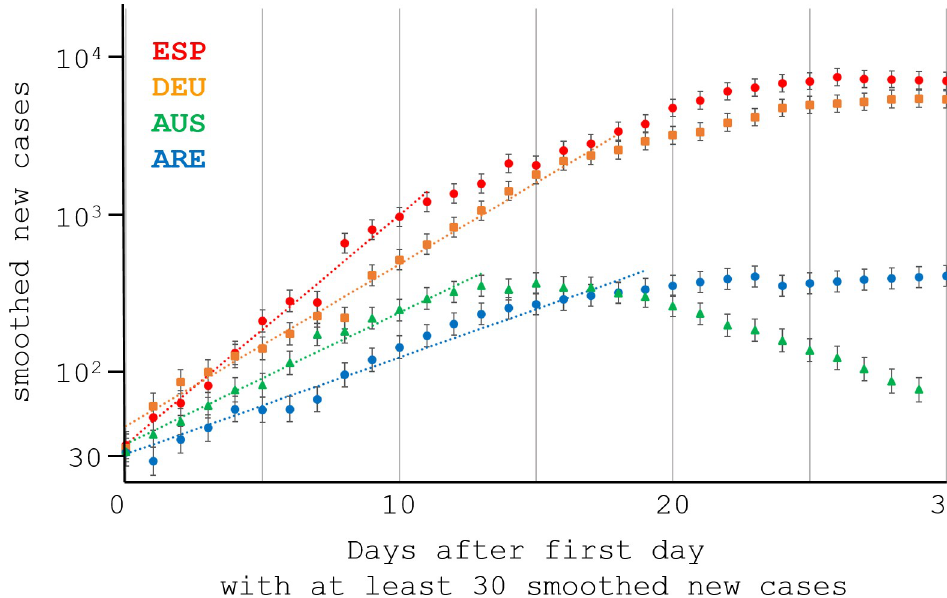
Fig 1. ARRP regime regression of the initial COVID-19 growth, illustrated with 4 countries. Fig 1 plots the smoothed new cases on a logarithmic axis against the days since the first day with at least 30 smoothed new cases. Fig 1 shows the exponential phase in 4 countries chosen for illustrative purposes, from top to bottom: Spain EPS (red circles), Germany DEU (orange squares), Australia AUS (green triangles), and United Arab Emirates ARE (blue circles). In the notation of the subsection “Regime regression” in the Materials and Methods, the points plotted are ( t , y ± ε ). Each dotted line displays an ARRP regime regression, described in the Materials and Methods. The largest X-coordinate of each line indicates the estimated transitional boundary terminating the exponential phase of the epidemic: Day 11 (EPS), 18 (DEU), 13 (AUS), or 19 (ARE). In the same order, the 4 countries yielded slopes r from the semi-log graph in Fig 1: 0.34, 0.24, 0.19, or 0.14. Generally, ARRP and visual estimation locate similar post-exponential transitions, particularly for: (1) a large regression slope (ESP or DEU); (2) large smoothed case numbers y , with concomitantly small errors ε (ESP or DEU); (3) a large fall in cases immediately after the post-exponential transition, possibly due to lockdowns or other non- pharmaceutical interventions (AUS); and (4) relatively little unmodeled, systematic noise in the data